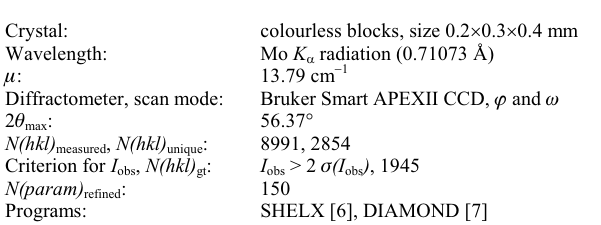
Table 1. Data collection and